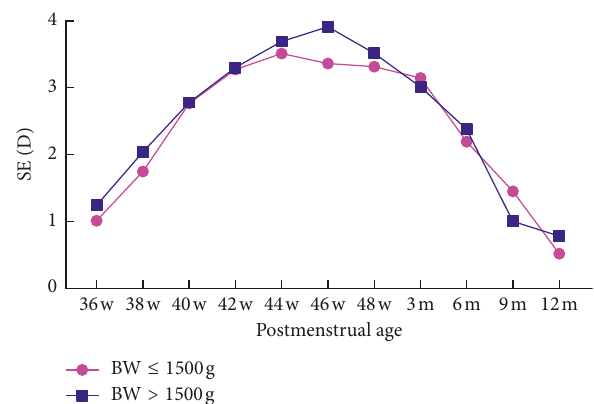
Figure 3: Correlation between SE and BW. SE, spherical equiv- alent; D, diopter; BW, birth weight.